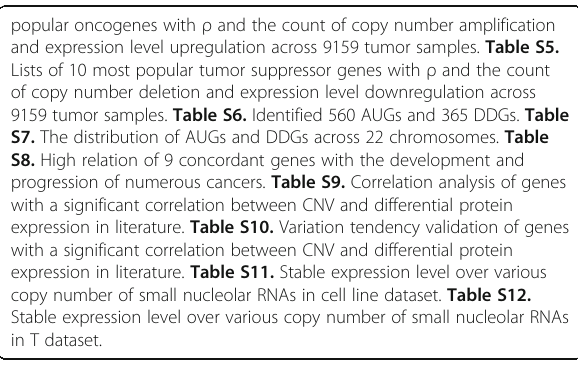
9159 tumor samples. Table S6. Identified 560 AUGs and 365 DDGs. Table S7. The distribution of AUGs and DDGs across 22 chromosomes. Table S8. High relation of 9 concordant genes with the development and progression of numerous cancers. Table S9. Correlation analysis of genes with a significant correlation between CNV and differential protein expression in literature. Table S10. Variation tendency validation of genes with a significant correlation between CNV and differential protein expression in literature. Table S11. Stable expression level over various copy number of small nucleolar RNAs in cell line dataset. Table S12. Stable expression level over various copy number of small nucleolar RNAs in T